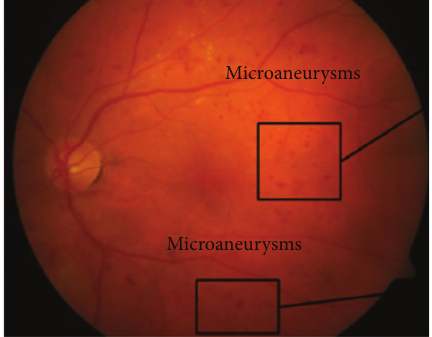
Figure 6: Microaneurysms in retinal